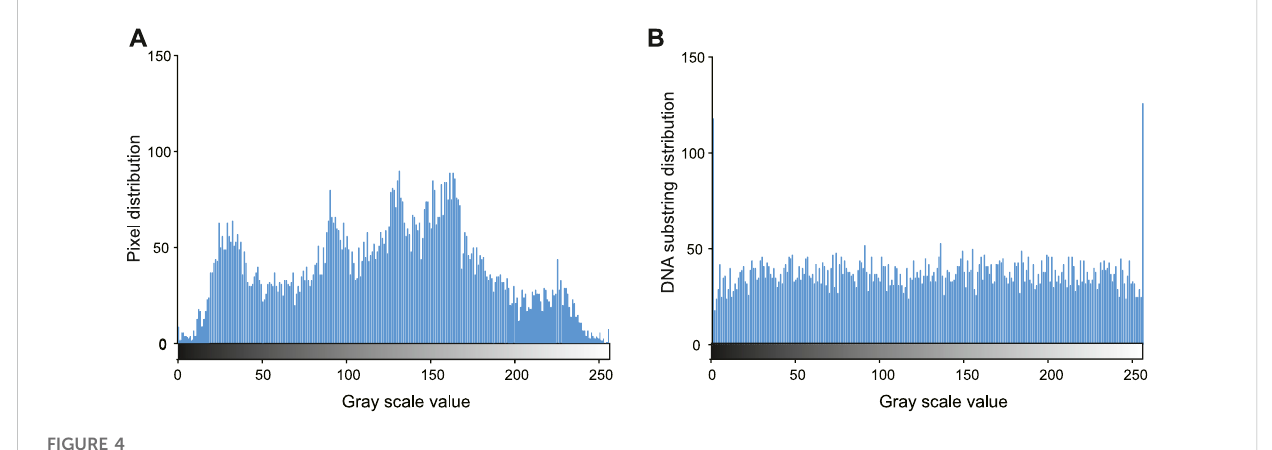
FIGURE 4 Distribution of pixel intensity histogram. (A) Plain image. (B) Encrypted image.